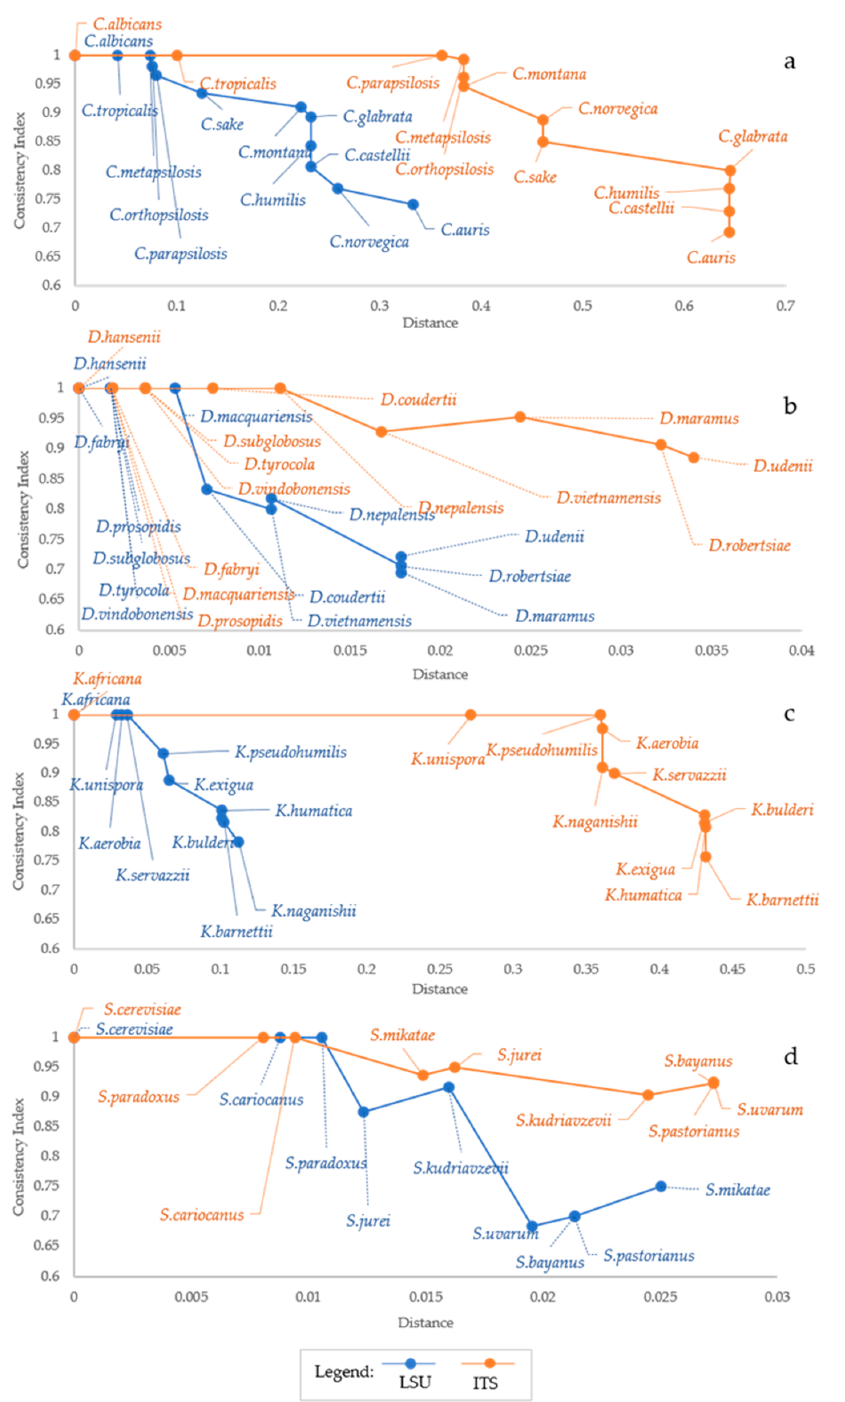
Figure 2. Relation between Distance and Consistency Index (CI). The plot shows the Consistency Index as a function of the distance (F84 distance model). Orange line represents data obtained from ITS sequence alignments while blue line is for LSU data. The figure highlights that CI (y axis) decreases with the increase of both distance (x-axis) and the number of species involved in the analysis (annotated directly on the figure). CI vs. distances trends of Candida, Debaryomyces, Kazachstania and Saccharomyces are reported in ( a ), ( b ), ( c ) and ( d ) respectively. Generally, CI values start decreasing with the fourth species added, only with Debaryomyces, it happened with the 7th and 9th species for LSU and ITS , respectively.